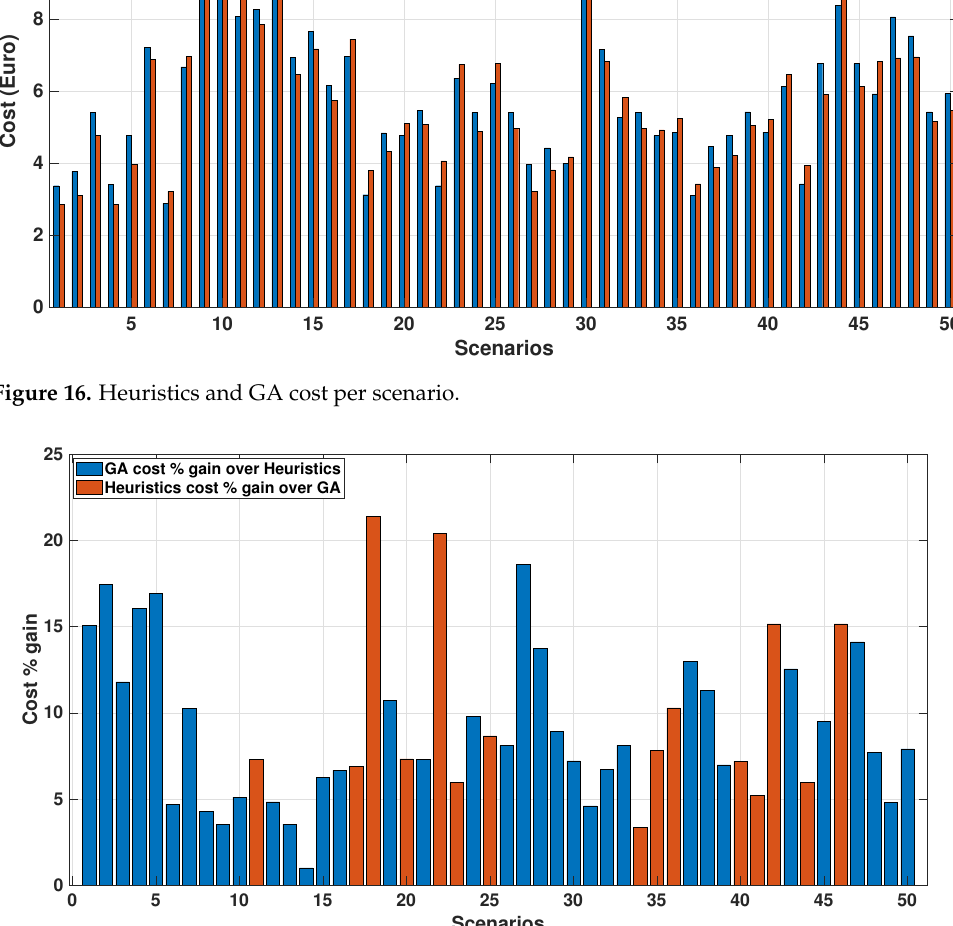
Figure 17. Cost percentage